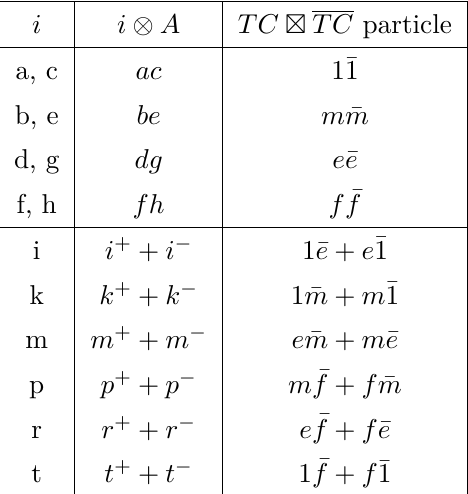
boson. The 6 fermions are { “ q + ” , “ q − ” , “ r + ” , “ r − ” , “ u + ” , “ u − ” } . Here we have used “ j +